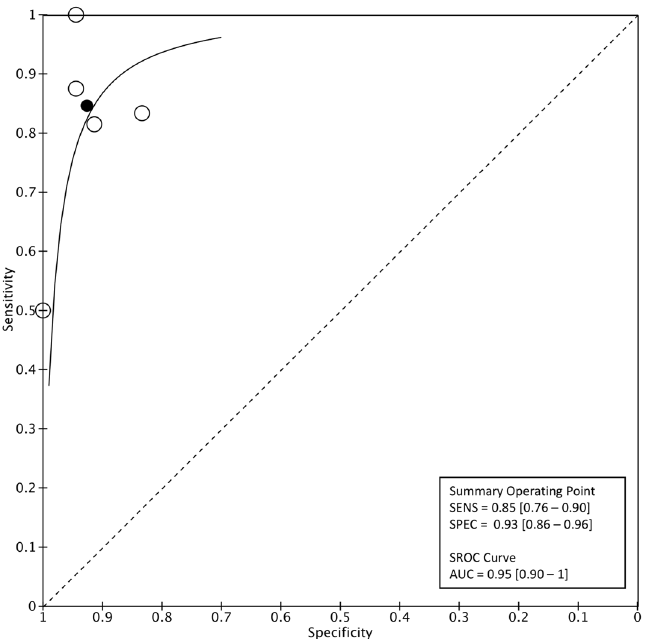
Figure 6. Level-2 classification algorithm for PSP: Summary ROC plot with mean operating sensitivity and specificity